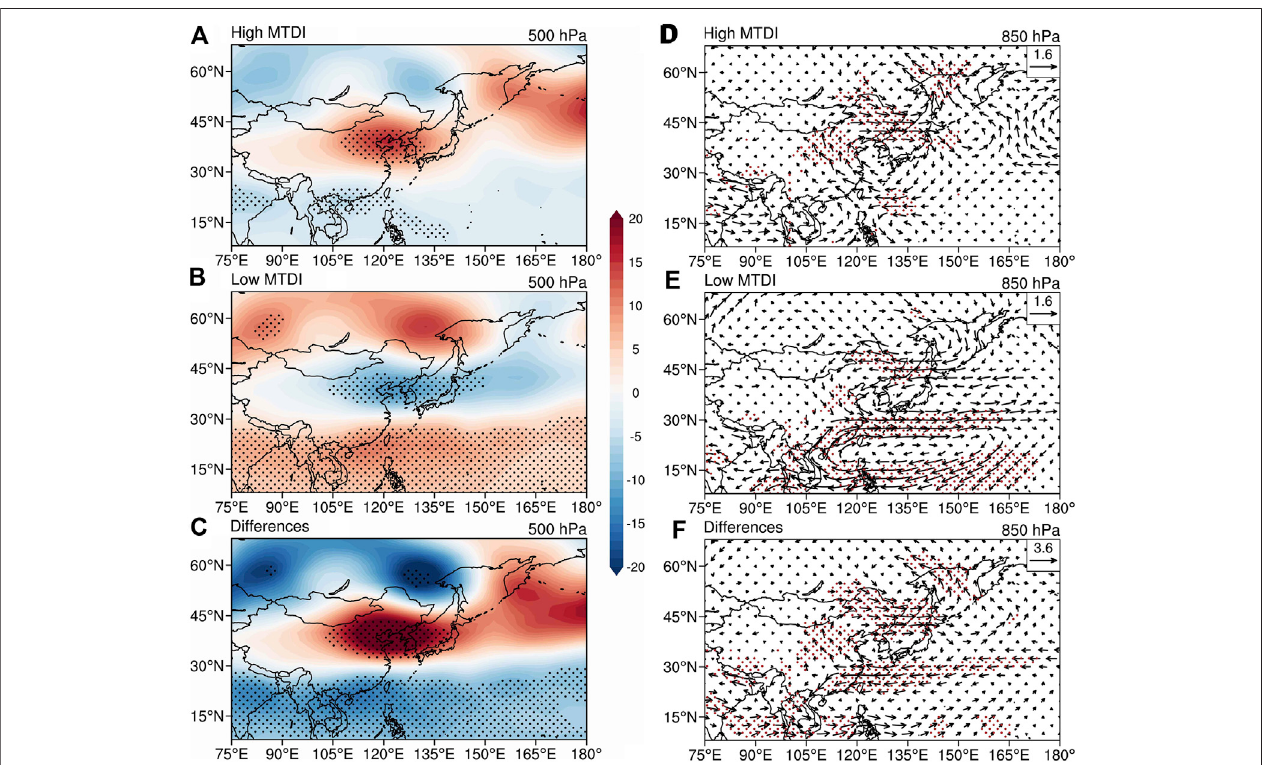
FIGURE5| CompositesofJJAgeopotentialheightanomalies(shading;gpm)at500 hPalevelsin (A) highMTDIyears, (B) lowMTDIyearsand (C) theirdifferences during 1950 – 2016. Composites of JJA wind anomalies (vector; m s − 1 ) at 850 hPa levels in (D) high MTDI years, (E) low MTDI years and (F) their differences during 1950 – 2016 (The letter A stands for anticyclone and C stands for cyclone). The dotted area refers to the place where the student ’ s t-test exceeds the 95% signi fi cance level.